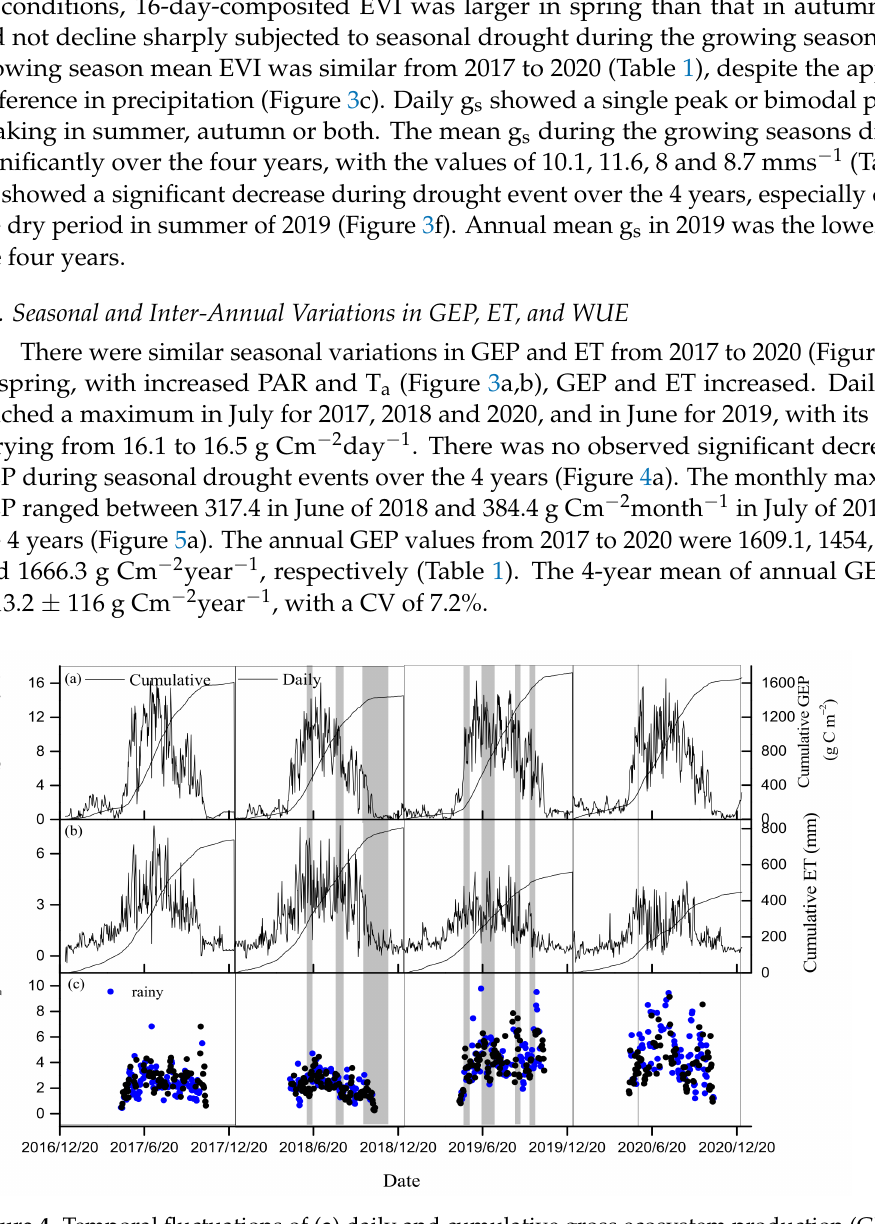
Figure 4. Temporal fluctuations of ( a ) daily and cumulative gross ecosystem production (GEP), ( b ) daily and cumulative evapotranspiration (ET), and ( c ) daily ecosystem water use efficiency (WUE) from 2017 to 2020. Blue circles denote rainy days greater than 2 mm in growing seasons. Gray-shaded bands in plot indicate dryness